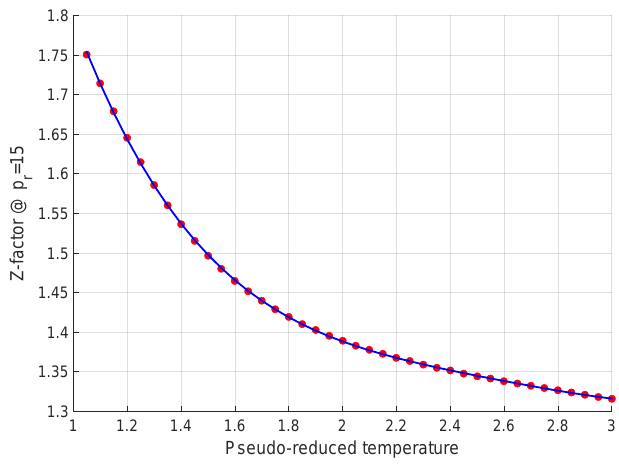
Figure 4. Z factor values at p r = 10 for various T r values.